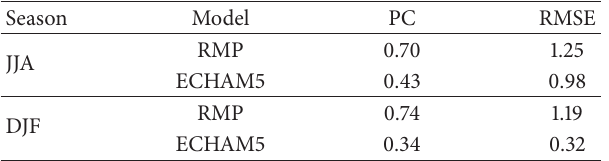
Table 1: Pattern correlation coefficient (PC) and root mean square error (RMSE, unit in mm/d) scores of simulated runoff from ECHAM5 run and RMP 20C experiment to the ISLSCP II reanalysis over Northeast